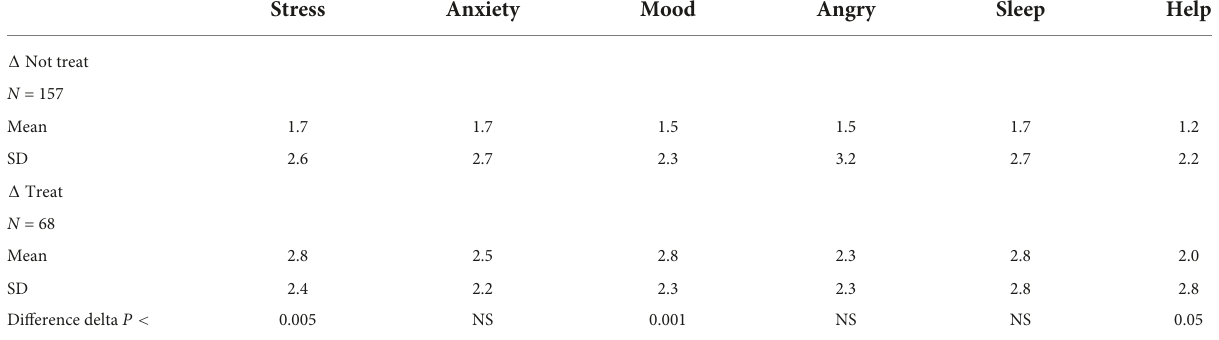
TABLE 4 THERMO. Stress Anxiety Mood Angry Sleep